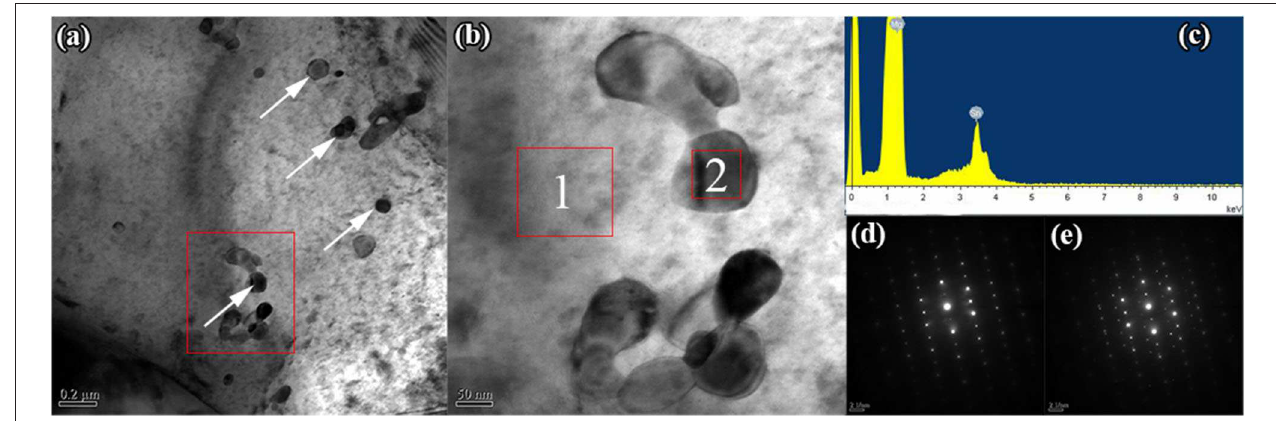
FIGURE 5 | Transmission electron microscopy image of as-extruded Mg − 1Sn − 0.1Ti alloy. (a) Bright-field image, (b) enlarged view of the red rectangle inset of (a) ; (c) energy dispersive x-ray spectroscopy result of the precipitate inset of (b) marked 2, and (d,e) selected area electron diffraction patterns of the matrix and the precipitate marked 1 and 2 in (b) , respectively.